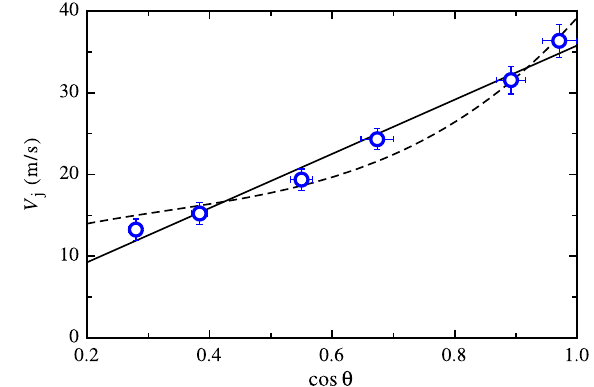
FIG. 6. Asymptotic jet velocity V of the initial contact angle. The solid line is a linear fit to the data. The dashed line is a 1 (cid:3) sin (cid:2) fit to the data suggested by Antkowiak et al. [9].